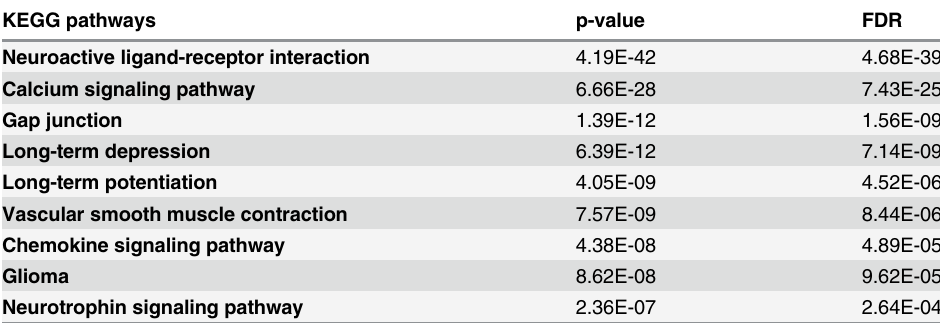
Table 1. The significant KEGG pathway lists (FDR < 5.00E-03) from 305 PD DDI-associated genes (except O75970 protein) using DAVID. KEGG pathways